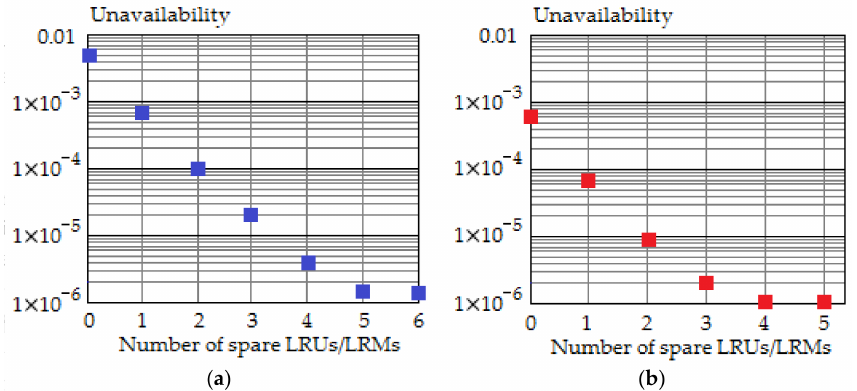
Figure 3. ( a ) Dependence of unavailability of the duplicated avionics system on the number of spare LRUs/LRMs when λ = η = 2 × 10 − 4 h − 1 ; ( b ) Dependence of unavailability of the duplicated avionics system on the number of spare LRUs/LRMs when λ = 2 × 10 − 4 h − 1 and η =